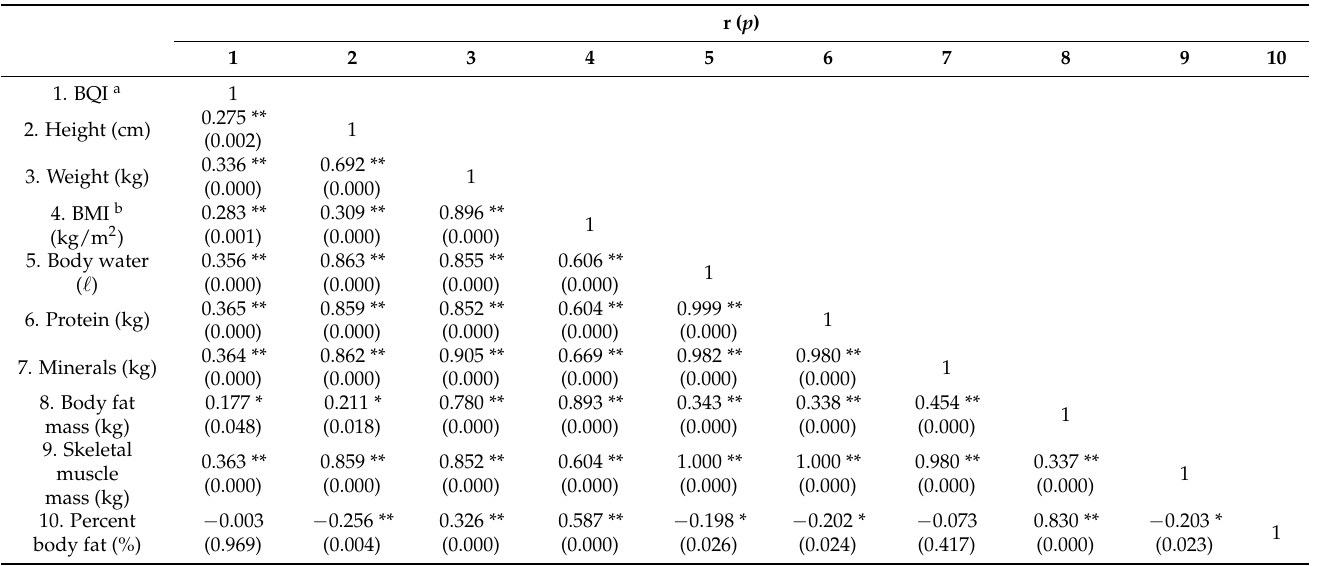
Table 3. Correlations between body composition and BQI ( n = 126).